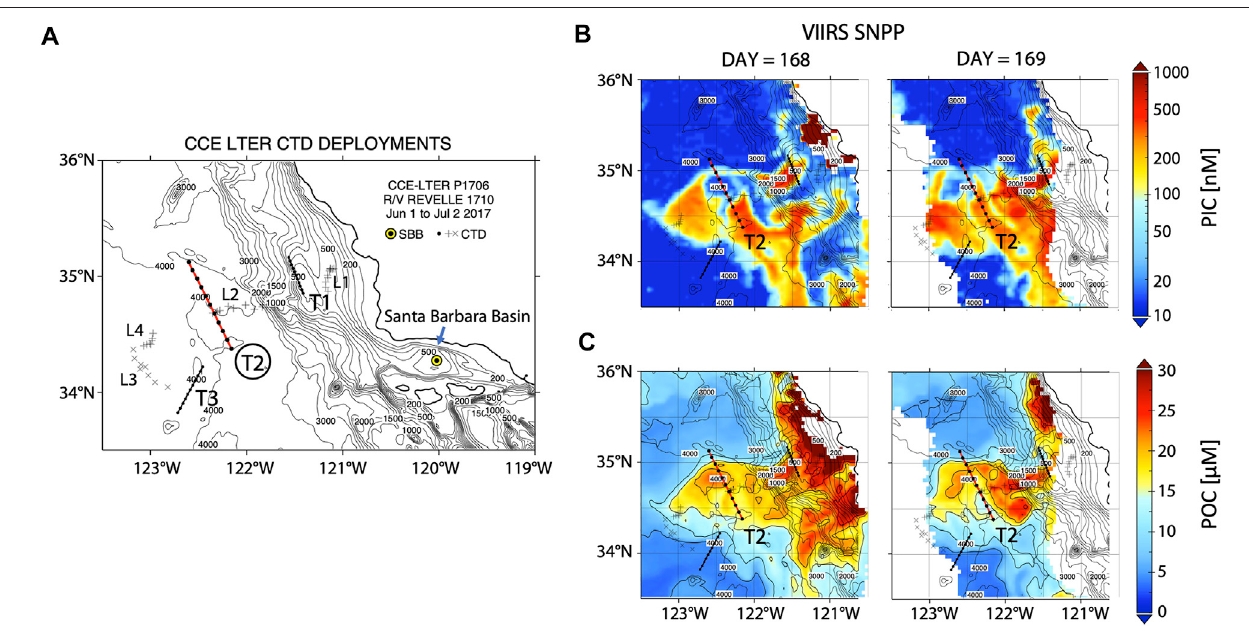
FIGURE3| SpatialcontextandsatellitedatafortheJune1 – July2,2017CCE-LTERprocessstudyofabiologicallyproductive fi lamentofoffshore fl owingupwelled water. (A) Map showing locations of CTD casts made during 5-day temporal sampling at locations L1, L3, and L4 (+) in the evolving fi lament and locations of cross- fi lament Transects T1, T2, and T3 (Bourne et al., 2021). Here, our focus is focuses on data from a PIC sensor deployed during 1 day CTD transects of the fi lament. TransectT2was occupiedduring day 169. (B) VIIRSSNPPsatelliteretrieved PIC for days168 and 169. (C) VIIRSNSPPsatelliteretrieved POC for days168 and